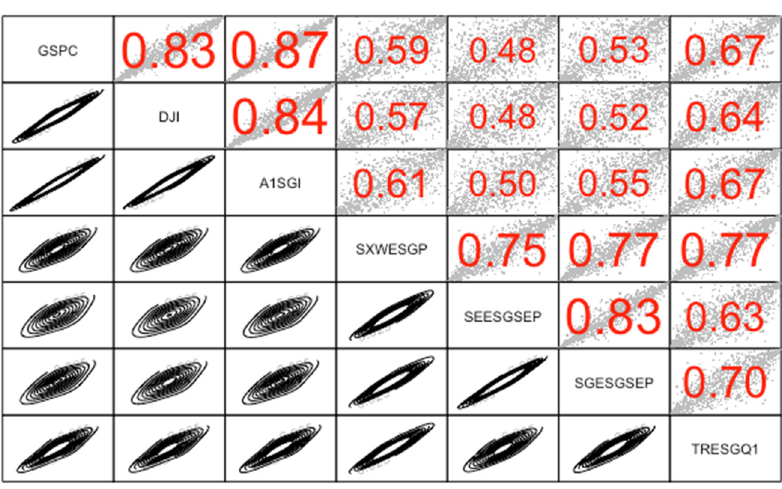
Figure 4. Kendall’s τ and copulas, 2 December 2009–30 July 2014.